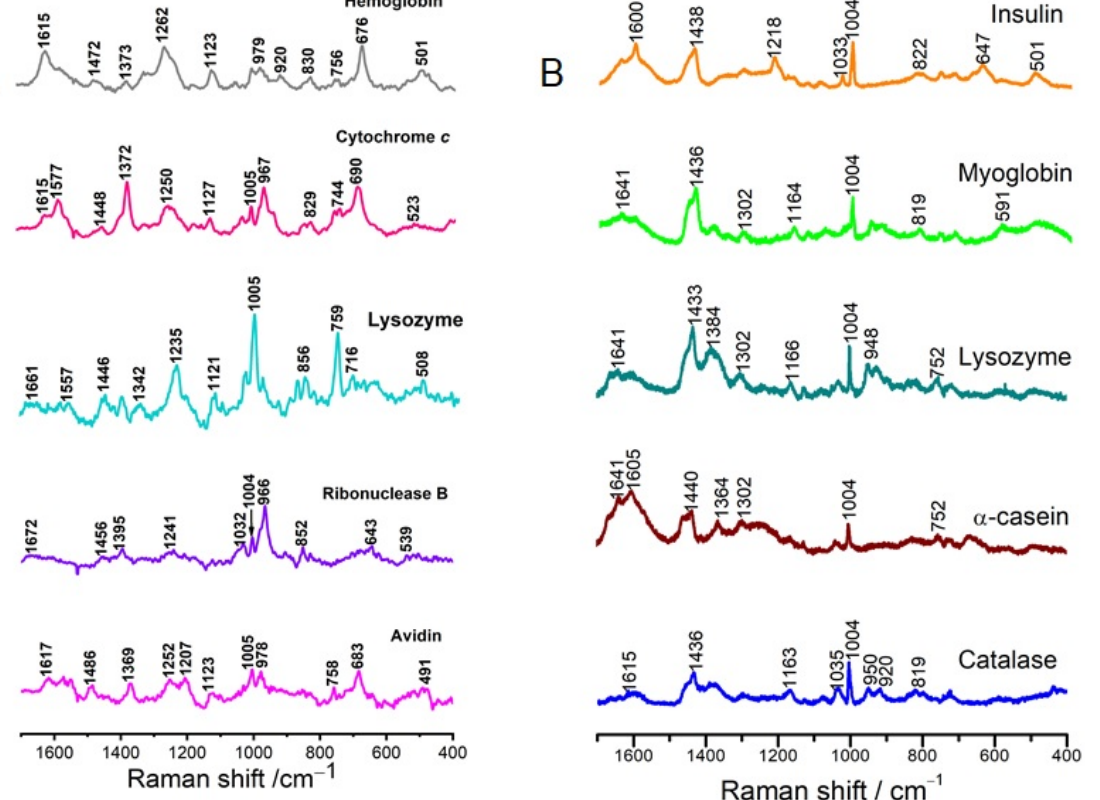
Figure 6. SERS of proteins collected from acidified sulfate-induced Ag aggregates with a 785 nm laser excitation ( A ), adapted with permission from [62]. Copyright [2009] American Chemical Society and ( B ) from aluminum and iodide ions-induced Ag aggregates with a 633 nm laser excitation, adapted with permission from [63]. Copyright [2020] American Chemical Society.